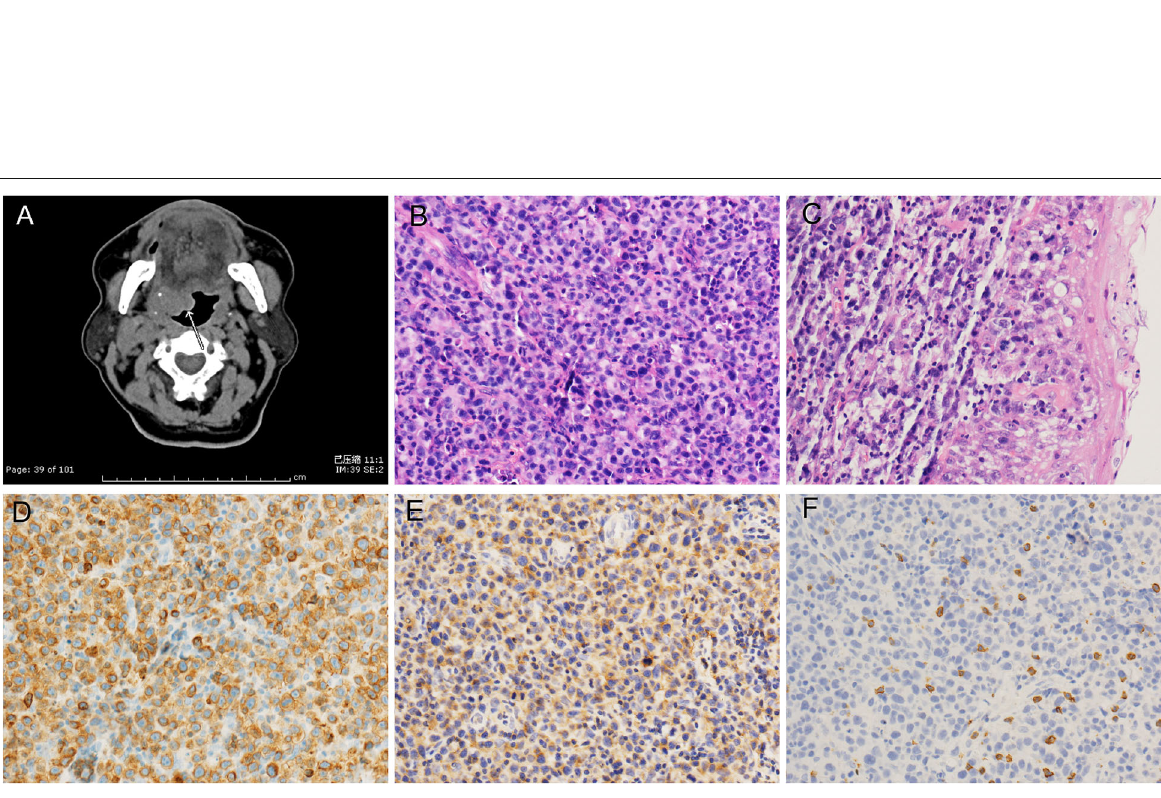
Fig. 3 Imaging and pathological findings of PTCL (case 3). a . CT showed a well-bordered cystic mass. b . H&E showed moderate to large cells with distorted nuclear contours (200 x). c . Tumour cell infiltrated squamous epithelium (400x). d . Tumour cells diffusely expressed CD3 (200x). e . Tumour cells were positive for CD4 (200x). f . Tumour cells were negative for CD8